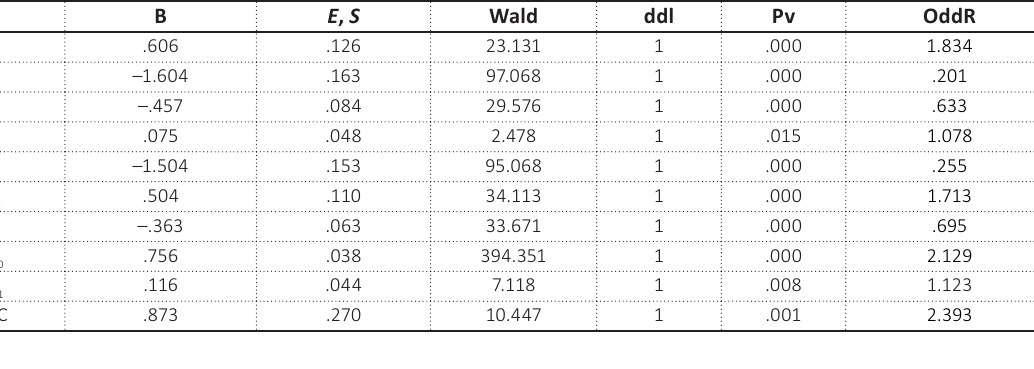
Table A4. Wald test table